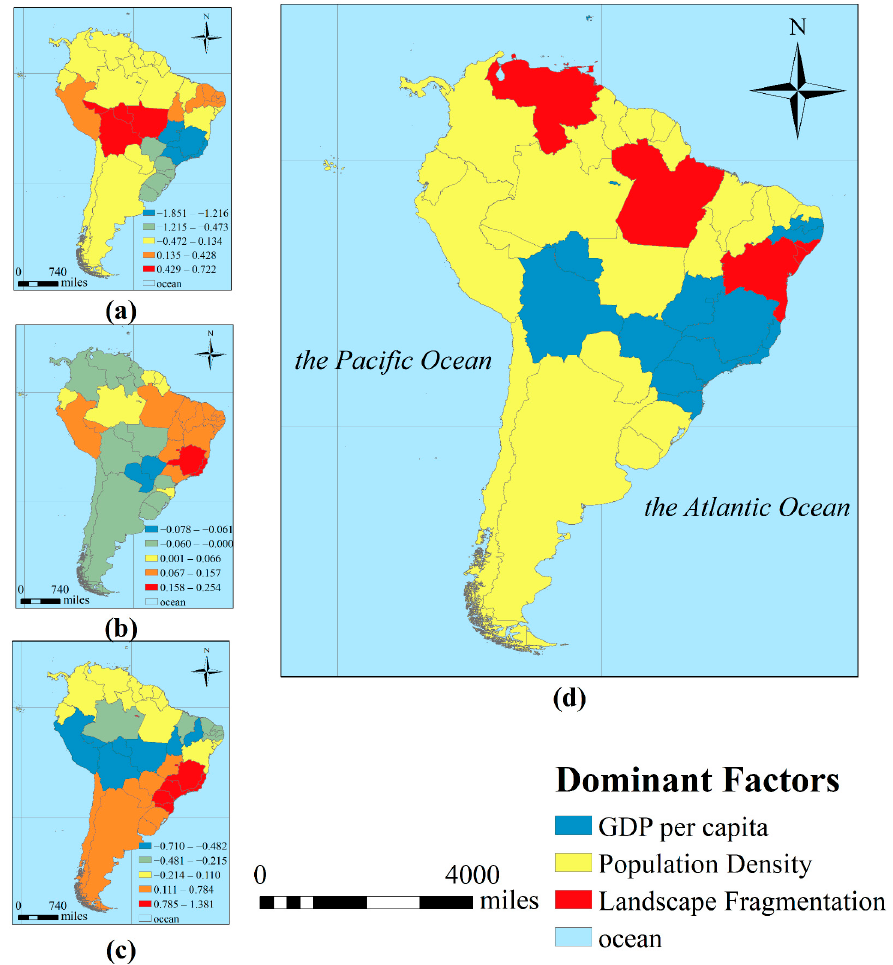
Figure 8. ( a – c ) is the regression coefficients of GDP per capita, landscape fragmentation and population density, respectively. ( d ) is the dominant factor impacting different